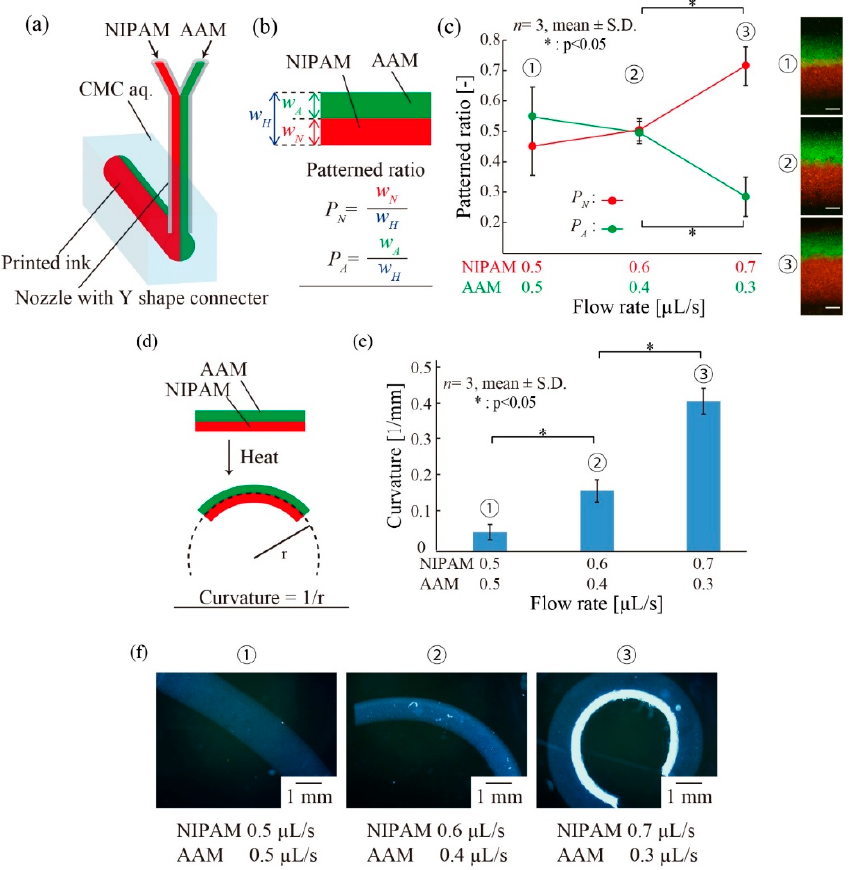
Figure 8. Printing of multi-hydrogel structures. ( a ) A schematic of the setup to print multi-hydrogel inks. The N-isopropylacrylamide-based stimuli-responsive pre-gel solution (NIPAM)-based pre-gel ink and the acrylamide-based non-responsive pre-gel solution (AAM)-based pre-gel ink were ejected into CMC aq via the nozzle attached to a Y shape connector. ( b ) The definition of the patterned ratios P N and P A which is obtained by the width of poly- N -isopropylacrylamide (pNIPAM) gel or polyacrylamide (pAAM) gel divided by the total width of the polymerized inks, respectively . ( c ) Results for the patterned ratios P N and P A with di ff erent flow rates Q. The scale bars are 500 µ m. The P N increased and the P A decreased when the flow rate of the NIPAM ink increased and that of the AAM ink decreased. ( d ) The definition of the curvature radius of a heated multi-hydrogels structure. ( e ) Results for the curvature radius of heated multi-hydrogels structures with di ff erent flow rates. The curvature increased when the flow rate of the NIPAM-based ink increased. ( f ) Images of the deformed multi-hydrogels